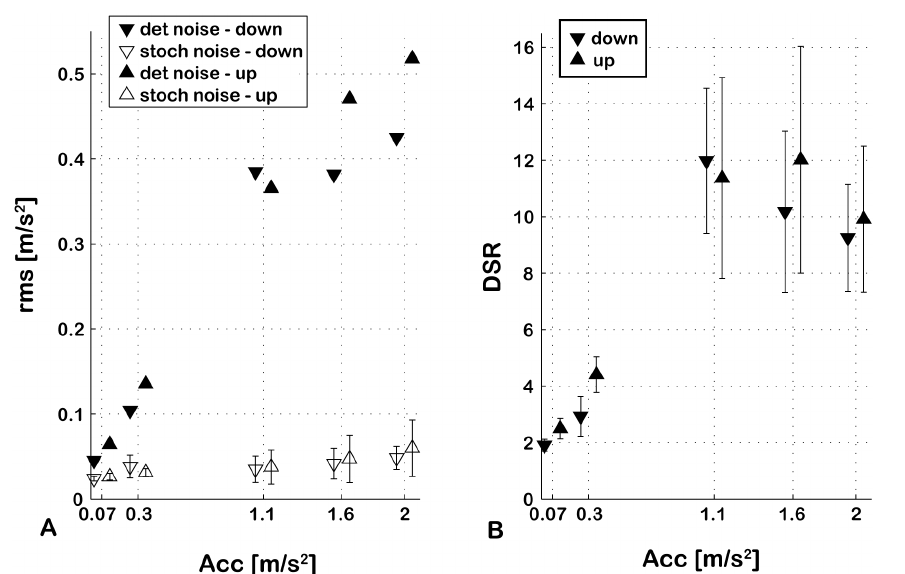
Figure 5. Relative contributions of deterministic and stochastic components to the total noise. Panel A: Each reference stimulus recording is associated with the rms of its deterministic (filled triangles) and stochastic component (empty triangles) for both upward (upward pointing triangles) and downward (downward pointing triangles) motions. Panel B: The DSR for upward and downward profiles. Both panels indicate a predominance of deterministic over stochastic noise in the recorded profiles. Error bars represent standard deviations of the 20 repetitions of each profile.